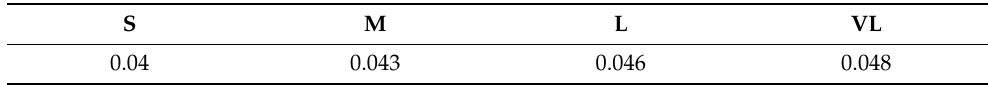
Table 2. X 1 Reference values in